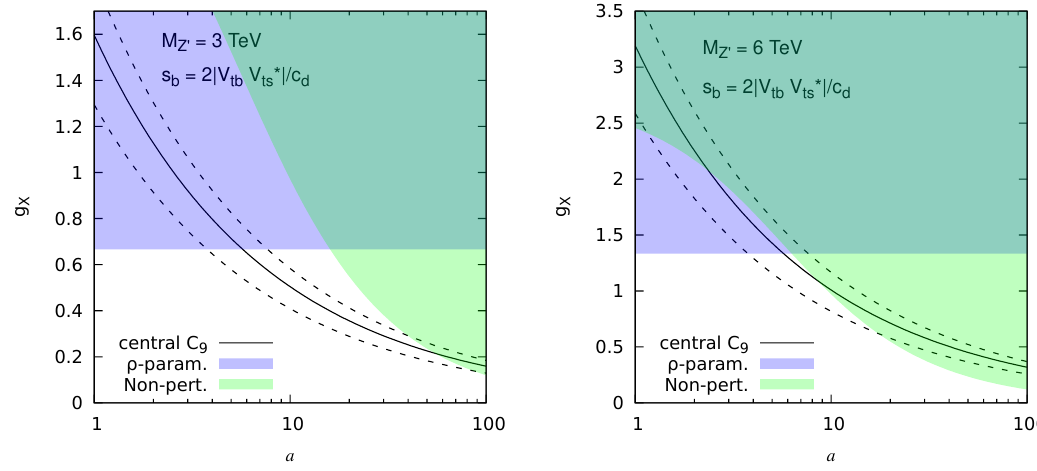
Figure 2 . Constraints on the gauge coupling g X , as a function of the parameter a , from demanding perturbative unitarity (specifically, from requiring the Z 0 width is no more than one third its mass). We plot the perturbative unitarity bound, together with the constraints from fitting the NCBA data and from the electroweak ρ -parameter, for two different values of the Z 0 mass; 3 TeV (left) and 6 TeV (right). In both plots, the white region between the dashed line contours is allowed at 95% CL. While there is a wide region of available parameter space fitting the NCBAs for a 3 TeV Z 0 boson, with the parameter a ranging between 6 and 50, for the heavier 6 TeV Z 0 it is only just possible to fit the NCBA data, and so the Z 0 mass cannot be pushed much higher (for any value of a ) without ¯ it becoming non-perturbative. In both plots, the constraint from B B s mixing is everywhere s − weaker than the ρ -parameter constraint. Likewise, the LEP LFU constraint is everywhere contained within the constraint from perturbative